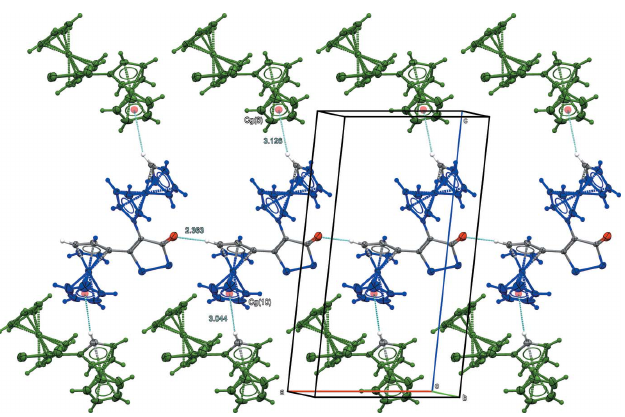
Figure 2 The molecular packing of the title compound showing intermolecular contacts of the type C—H (cid:3)(cid:3)(cid:3) O forming graph set motifs C 1 axis, as well as C—H (cid:3)(cid:3)(cid:3) (cid:2) interactions parallel to the ac plane. Molecule A is green, molecule B is blue.